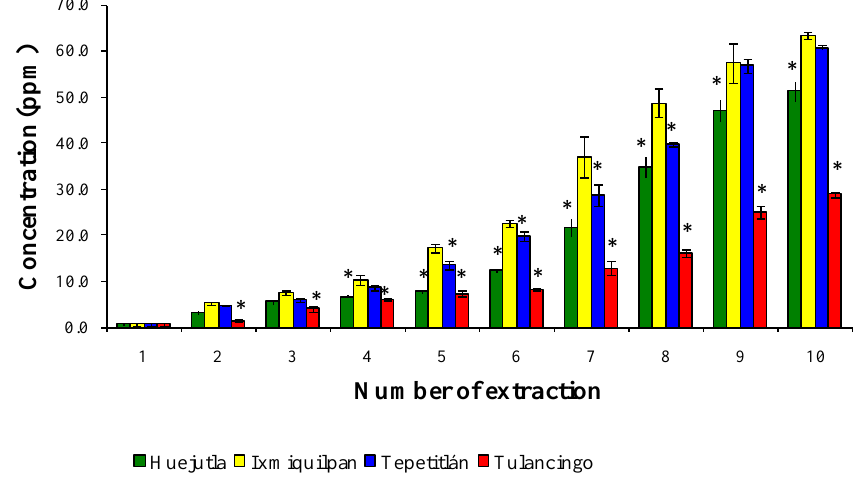
Figure 3. Concentration of Pb leached from the glass-clay containers into the green tomato sauce (salsa). The bars show the mean values of the four regions studied along with their standard deviations. * Indicates significant statistical differences with respect to the Ixmiquilpan region, which represents the highest concentration of the metal; p ≤ 0.05.